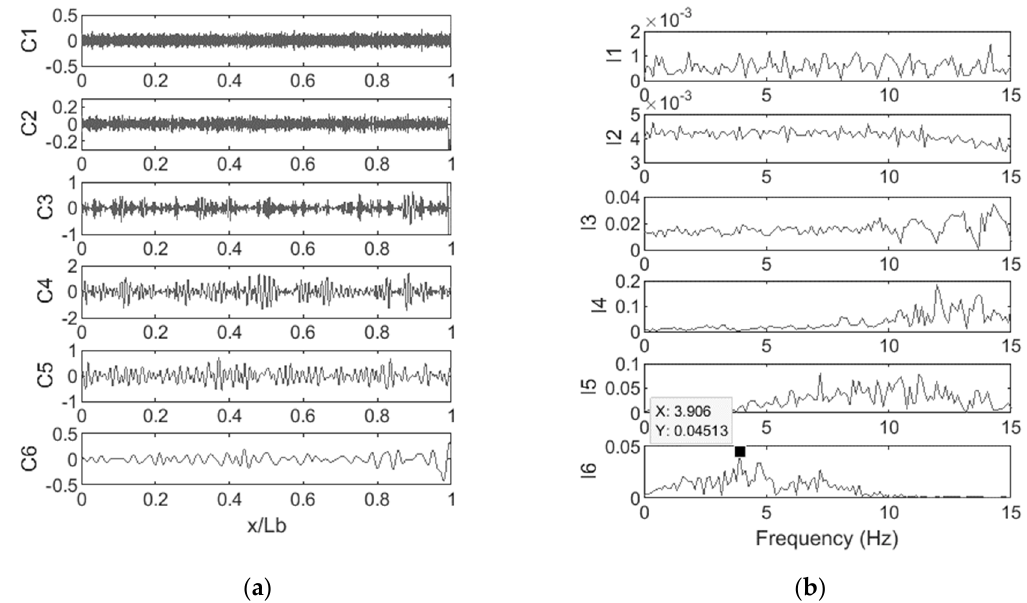
Figure 11. ( a ) IMFs of the vehicle acceleration response and ( b ) FFT of IMFs when the vehicle speed is 5 m/s.